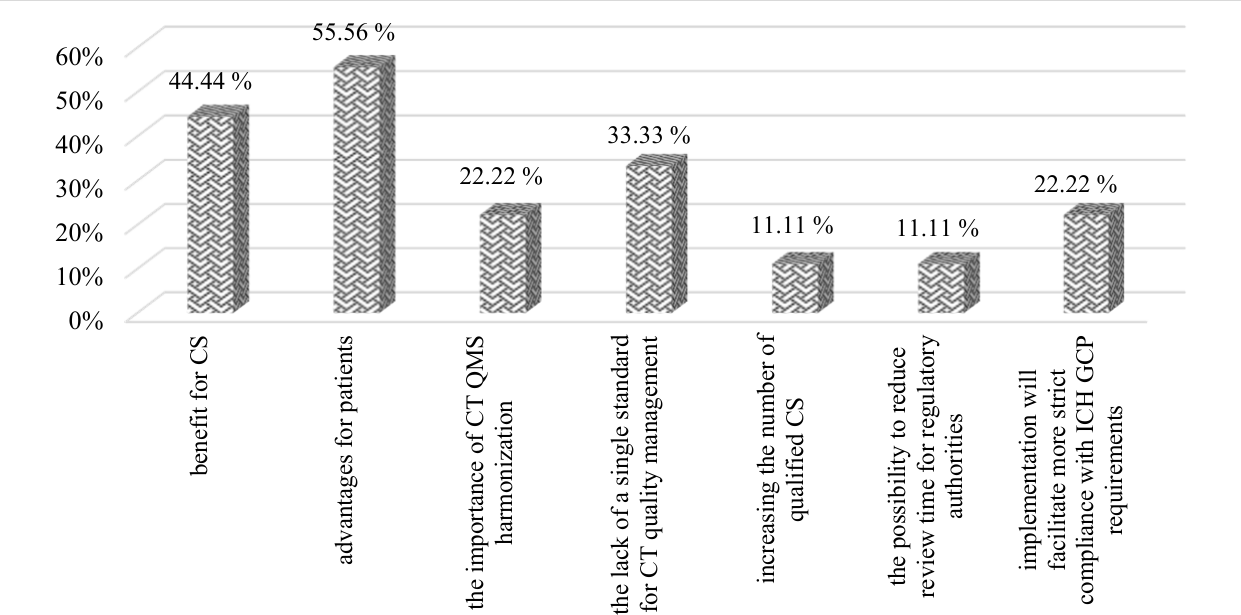
Fig. 2. Reasons for the need of the CTQMS implementation according to the regulatory authorities’